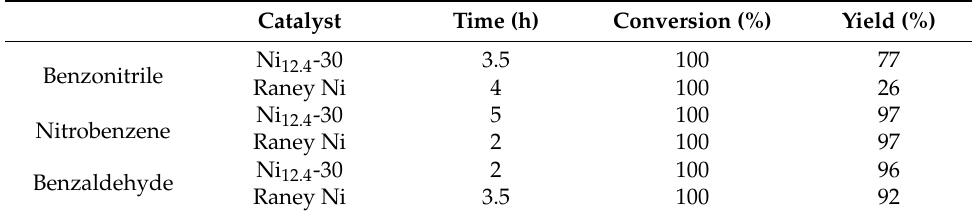
Table 7. The comparison between two catalysts.